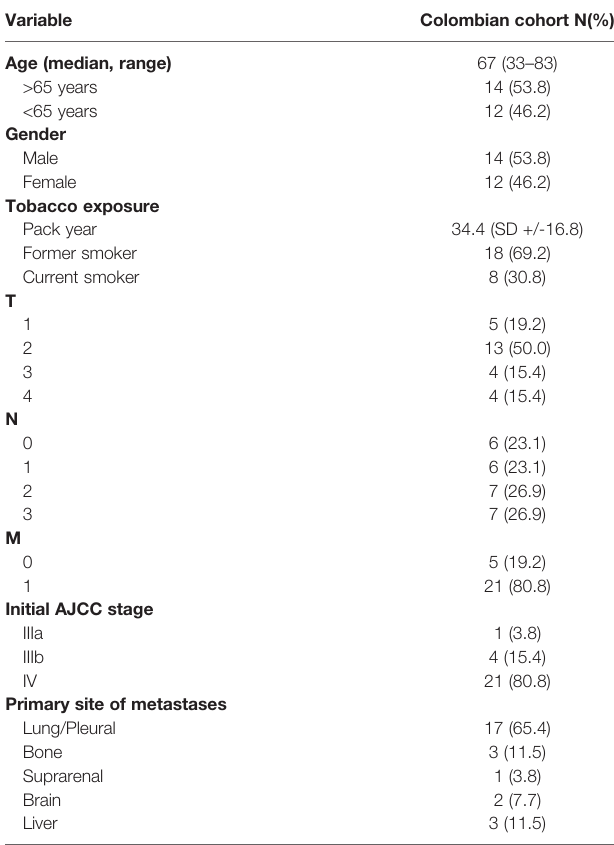
TABLE 1 | Demographic characteristics of Colombian patients with lung